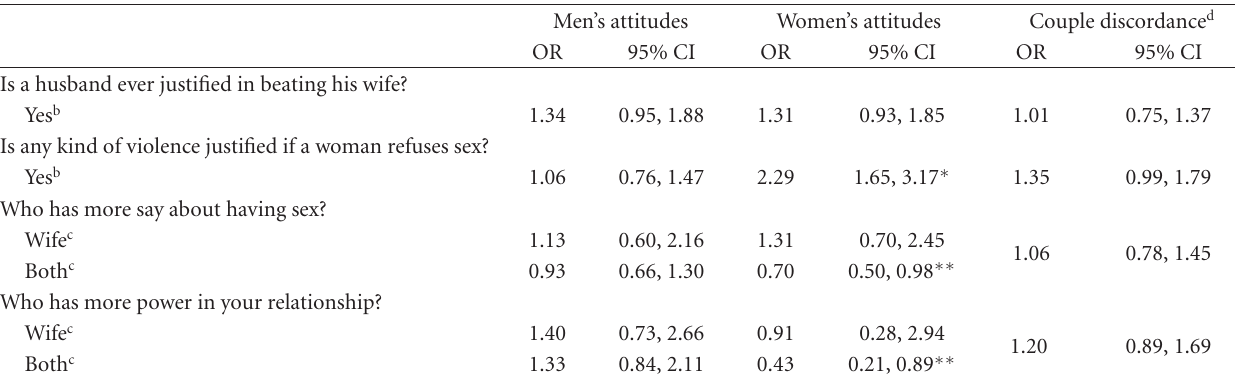
Table 3: Men’s and women’s attitudes as predictors of women’s IPV report, multivariable logistic regression